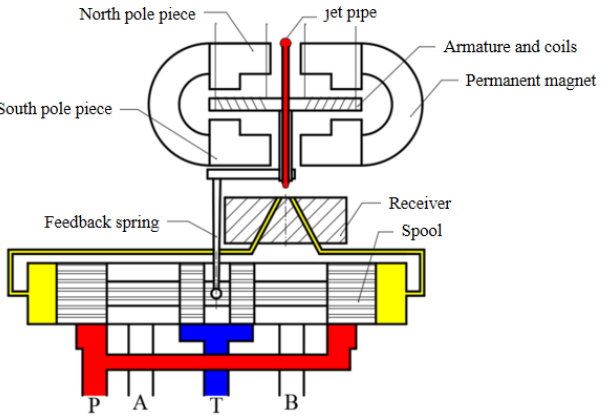
Figure 1. Schematic of jet pipe servo-valve. Red represents high pressure oil, yellow represents working oil, and blue represents oil flowing back to the tank.